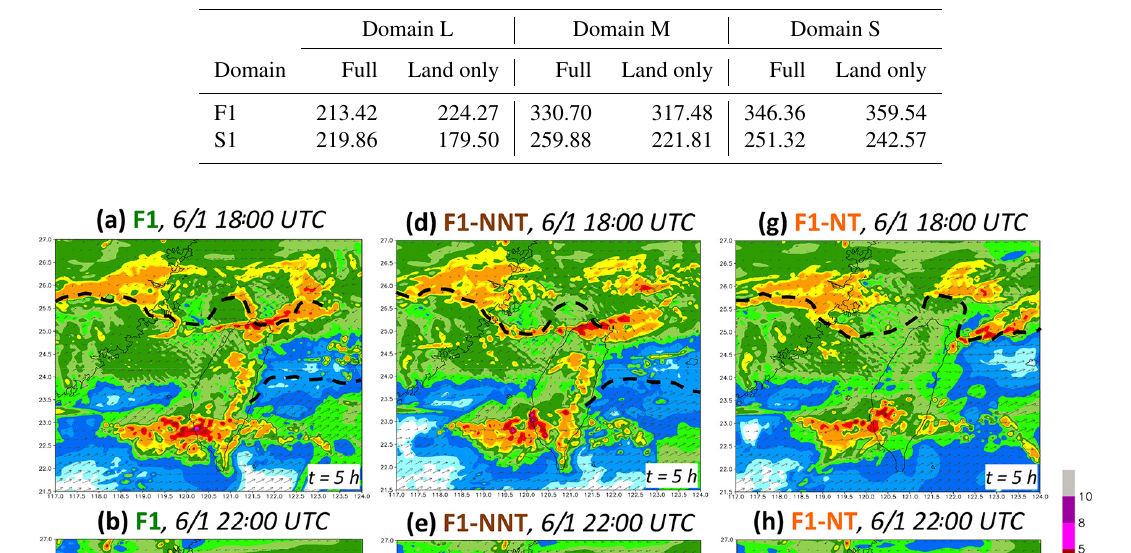
Table 4. Comparison of areal-averaged 24h rainfall (mm) inside the three domains, denoted as large (L) domain (24.85–25.65 ◦ N, 120.75– 122.15 ◦ E), middle (M) domain (25.05–25.45 ◦ N, 121.1–121.8 ◦ E), and small (S) domain (25.1–25.3 ◦ N, 121.35–121.8 ◦ E), respectively, in experiments S1 and F1 during their selected 24h period (starting from 00:00UTC on 1 June for S1 and 16:00UTC on 1 June for F1). The three domains are depicted in Fig. 9, and the mean rainfall values are given for the full domain and land only.